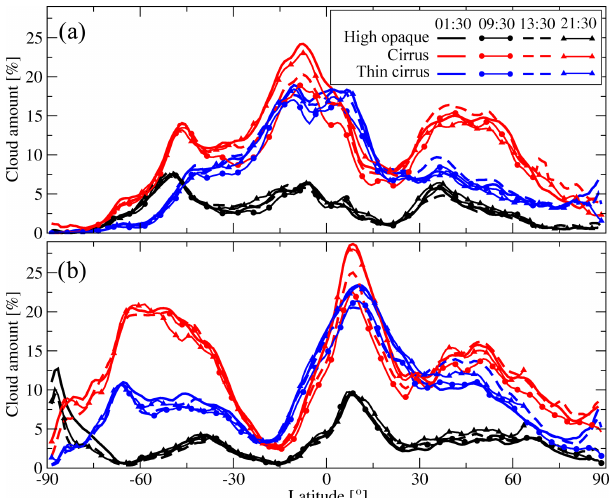
Figure 1. Latitudinal distribution of high opaque, cirrus, and thin cirrus cloud coverage estimated from AIRS (01:30 and 13:30LT) and IASI (09:30 and 21:30LT) by the CIRS retrieval: (a) January; (b) July. Climatological averages over 2008 to